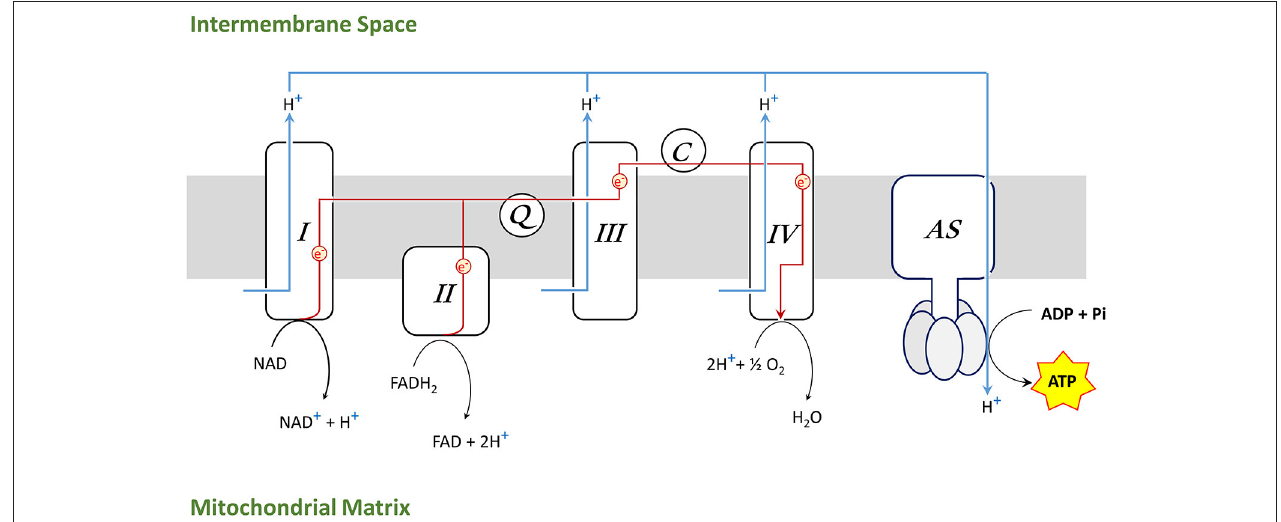
FIGURE 2 | Electron transport chain (ETS) in the inner mitochondrial membrane [complexes I–IV, ATP synthase (AS), coenzyme Q (Q), cytochrome C (C)].